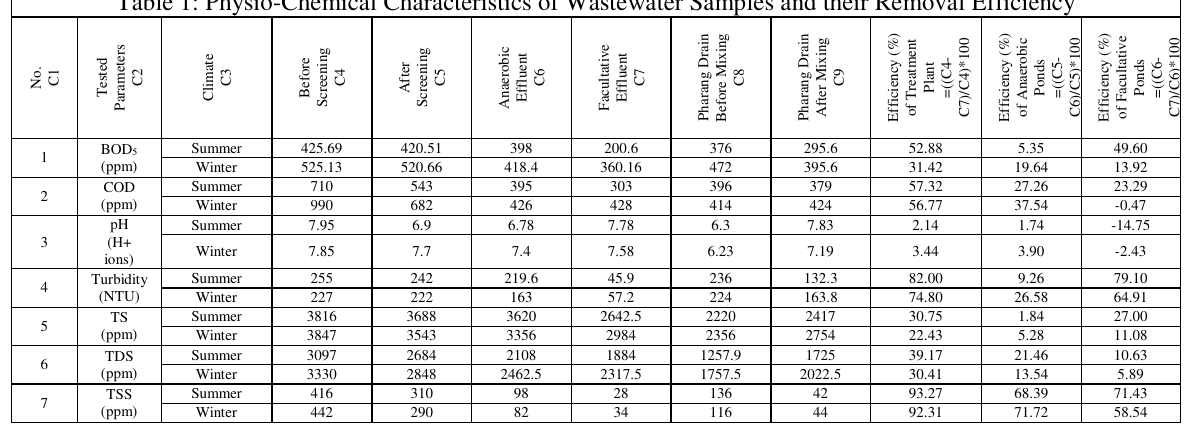
Table 1: Physio-Chemical Characteristics of Wastewater Samples and their Removal Efficiency . C N o